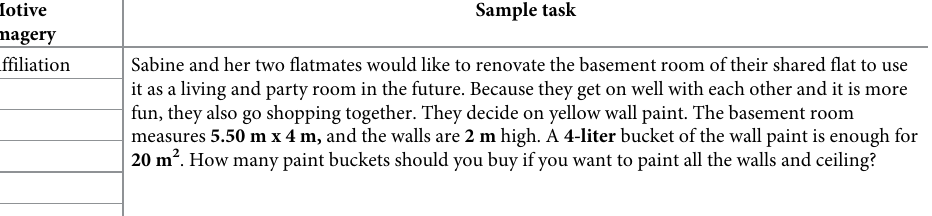
Table 1. Sample tasks for the mathematical topic “direct and inverse